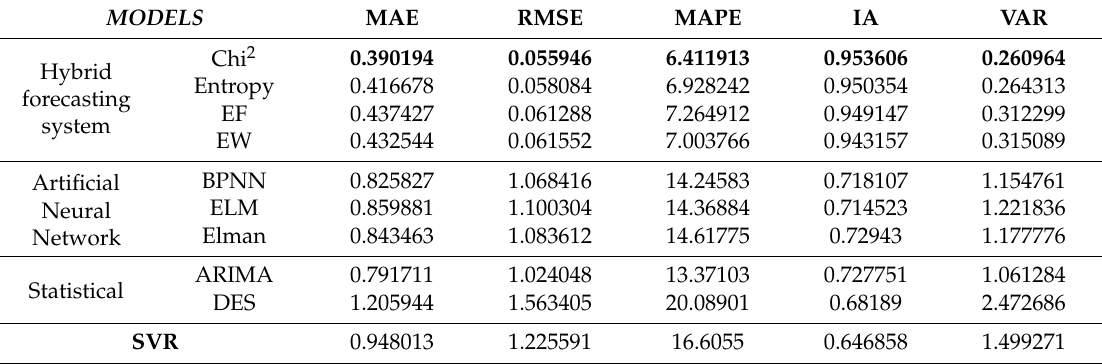
Table 14. Comparison of different models for the hourly time horizon wind speed forecasting.